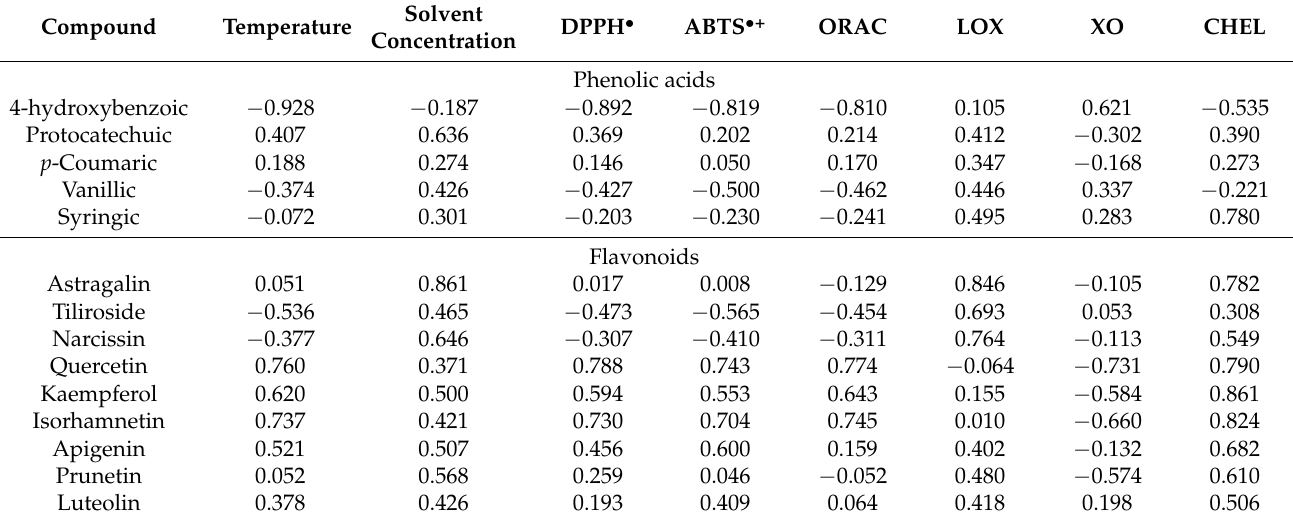
Table 6. Pearson’s correlation coefficients ( r ) showing a relationship between the content of phe- nolic acids and flavonoids determined with the LC/MS method and the extraction conditions and biological